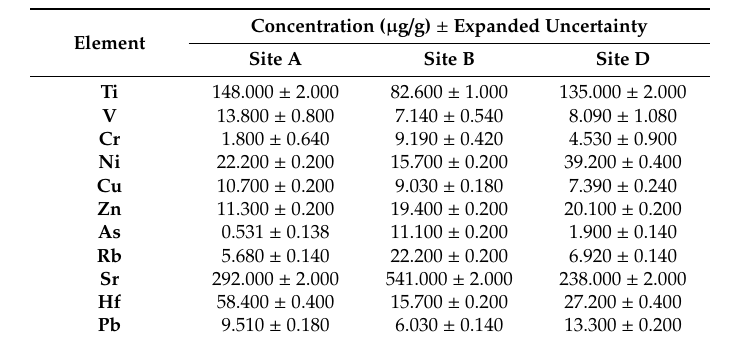
Table 3. Element concentrations ( ± measurement expanded uncertainty, expanded factor k = 2) determined in Ulva pilifera using total reflection X-ray fluorescence (TXRF) technique. Concentrations are given µ g / g. The analysis were done only from sites A, B, and D while site C was below the limit of